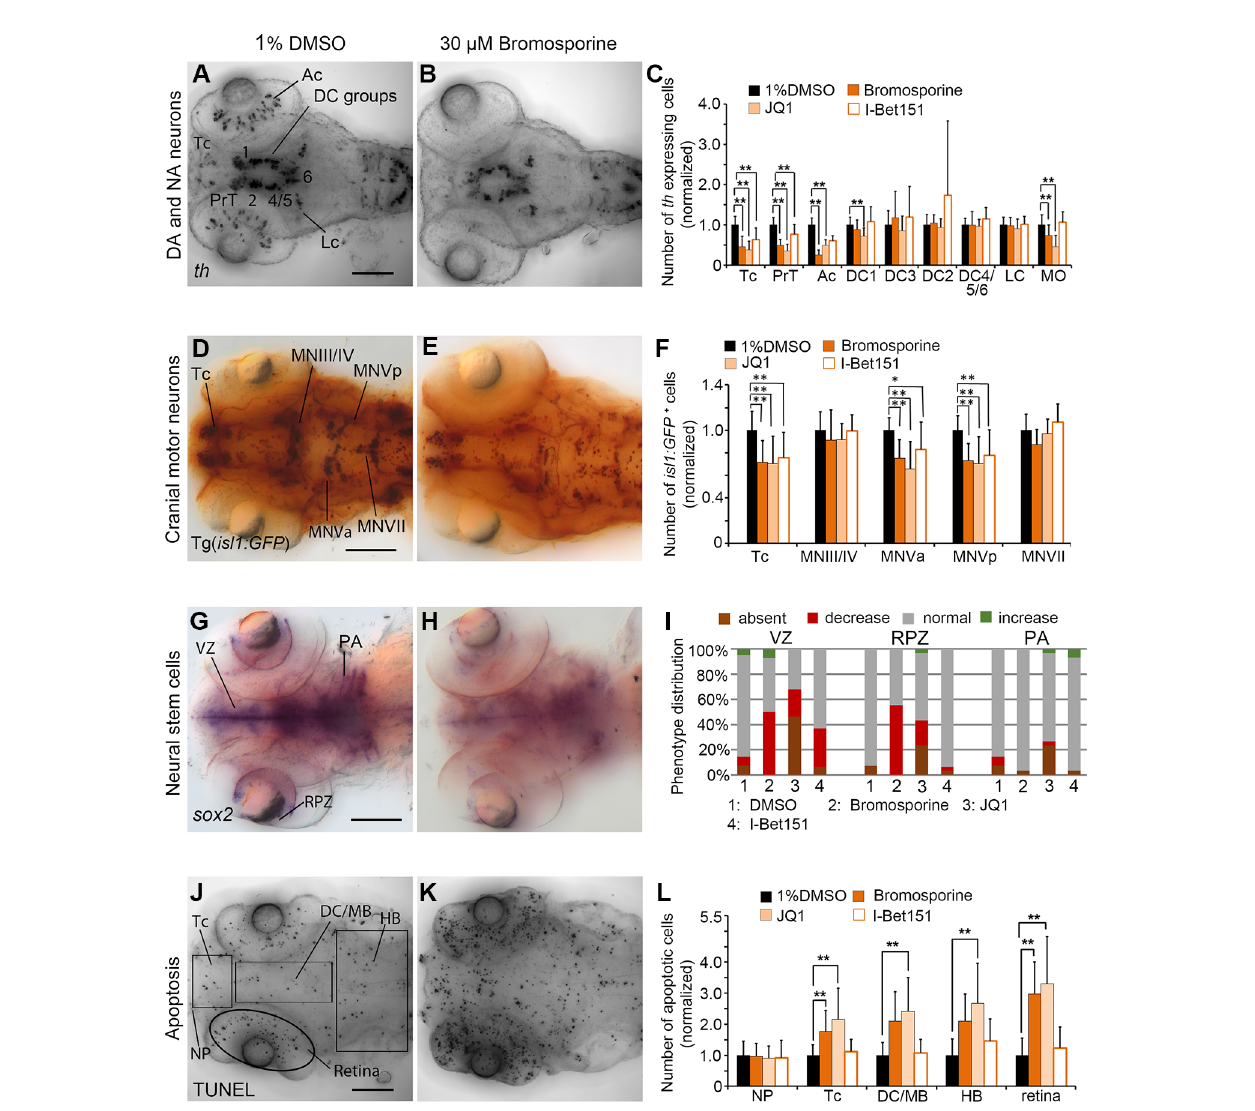
FIGURE 6 | Quanti fi cation of Secondary Screen — Bromodomain inhibitors. (A – C) Analysis of th expression (WISH) for DA and NA neuron development. (D – F) Immunohistochemistry for Isl1-GFP positive cranial motor neurons. (G – I) WISH analysis of sox2 expression in neural stem cells. (J – L) TUNEL assay to detect apoptotic cells. Embryos were treated with the Bromodomain inhibitors Bromosporine, JQ1 or I-Bet151 from 24 to 72 hpf and fi xed at 96 hpf. (A, B, D, E, G, H, J, K) Dorsal views of heads of larvae, images generated from Z-Projections of image stacks, anterior at left. Scale bars represent 100 µm. Bar charts illustrate the mean cell count numbers of each neuronal subtype for (C) th expressing cells, (F) isl1:GFP transgene expressing cells, (L) apoptotic cells. Error bars depict standard deviation of the mean. Asterisks indicate signi fi cant differences compared with the 1% DMSO control (p < 0.001). (I) For analysis of sox2 expression, embryos were classi fi ed into absent, decreased, normal or increased sox2 expression phenotypes (see color code), embryo numbers were normalized to 100%. AC, amacrine cells; DA, dopaminergic; NA, noradrenergic; Tc, telencephalon; PrT, pretectum; DC, diencephalic groups; Lc, locus coeruleus; MO/AP, medulla oblongata/area postrema; MN, motor neuron cluster; VZ, ventricular zone; RPZ, retinal proliferation zone; PA, pharyngeal arches; NP, nasal placodes; DC/MB, diencephalon and midbrain region; HB,